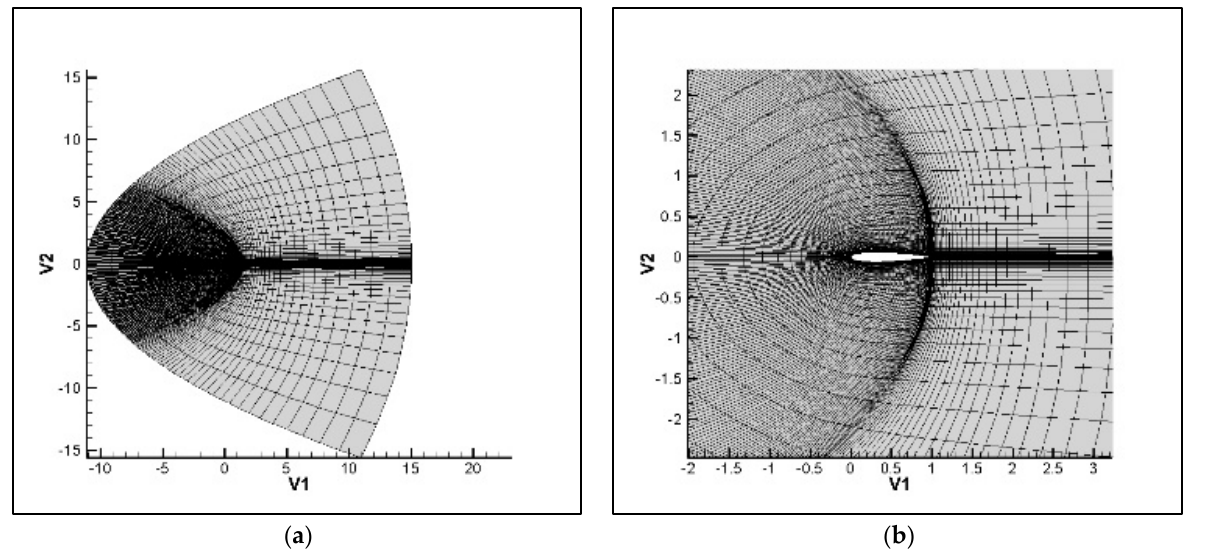
Figure 5. Grid topology of NACA0012: ( a ) global view of grid; ( b ) partial enlargement of grid. Grid refinement was tested by medium grids with 265 × 65 1.7 × 10 4 grid nodes, and fine grids with 401 × 73 2.9 × 10 4 grid nodes, respectively. Minimum grid spacing adjacent to the wing surface was set to 0.0001 c (less than c / R e ). The outer boundary of the grid was set as 20 chord lengths in the spanwise direction. In order to verify the feasibility of sub-time steps per time step, 20 and 50 sub-time steps per period were tested, respectively, using the medium grid. Figure 6 shows lift coefficients of three cases mentioned